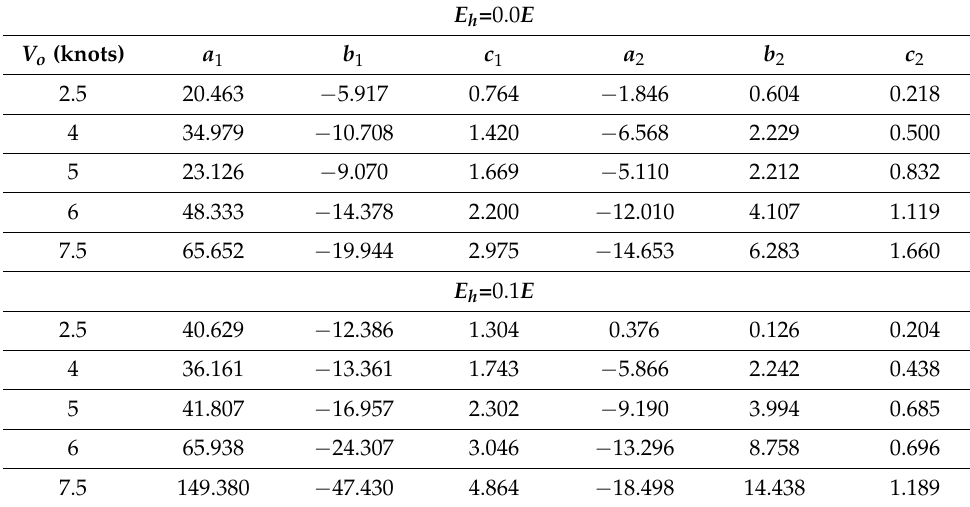
Table 5. Coefficients for Equations (3) and